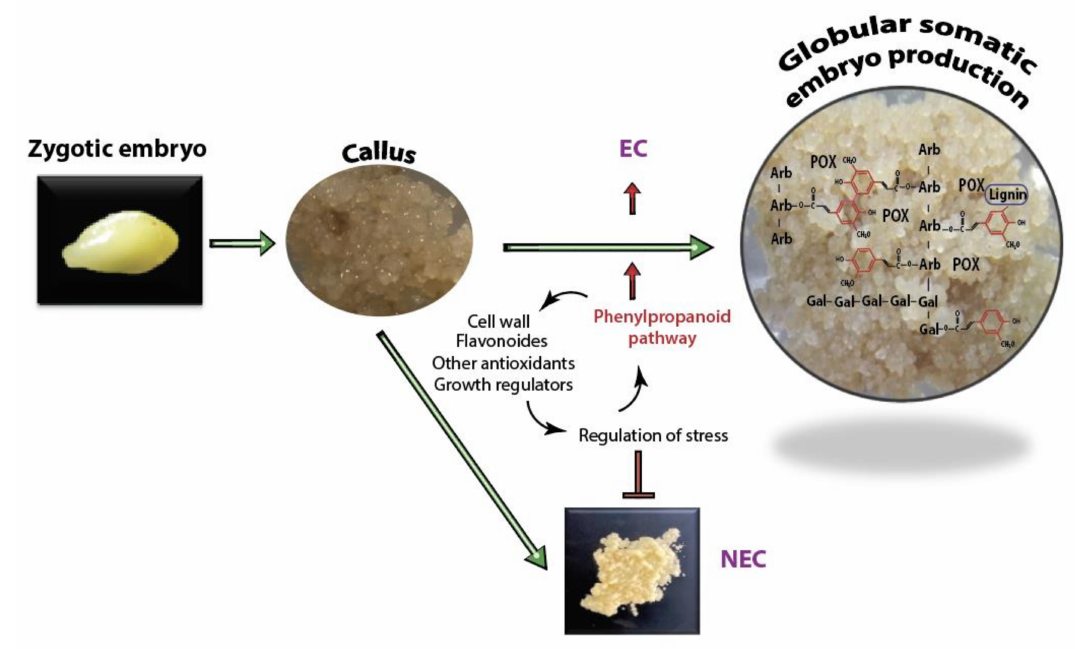
Figure 6. A model of cell wall reinforcement and regulation of stress condition mediated by the phenylpropane pathways and growth regulators in avocado somatic embryogenesis. In dicots, ferulic acid is bound to pectic polysaccharides, including the C-2 hydroxyl group of arabinofuranose (Arb) and C-6 hydroxyl group of galactopyranose (Gal). Peroxidases (POX) catalyze the oxidation of ferulic acid, leading the formation of ferulic acid dehydrodimers. The depiction of ferulic acid in the cell wall modified from Mathew and Abrahan